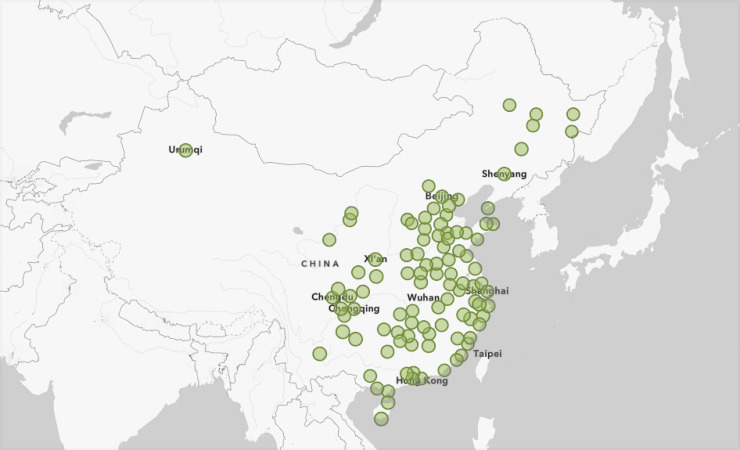
The 102 Chinese cities selected in the study.